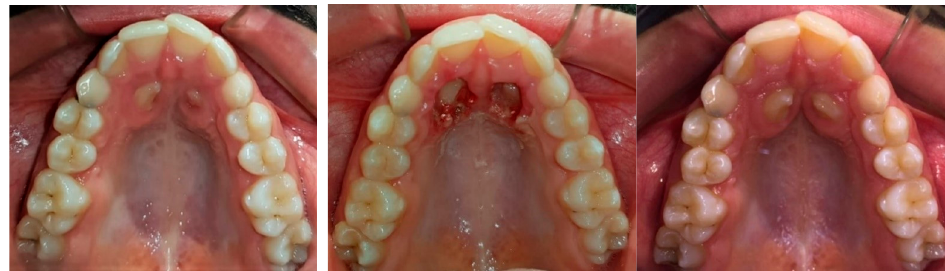
Figure 7. Intraoral photo at 1 week ( left ), 8 weeks ( middle ) and 16 weeks ( right ) after CO 2 laser surgery, that show the spontaneous eruption of the canines on the palate.